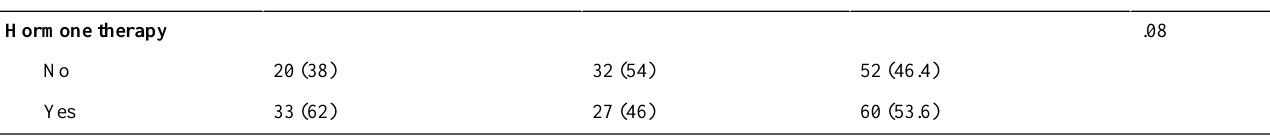
P valueTotal summary scores a , P valueGlobal health status mean